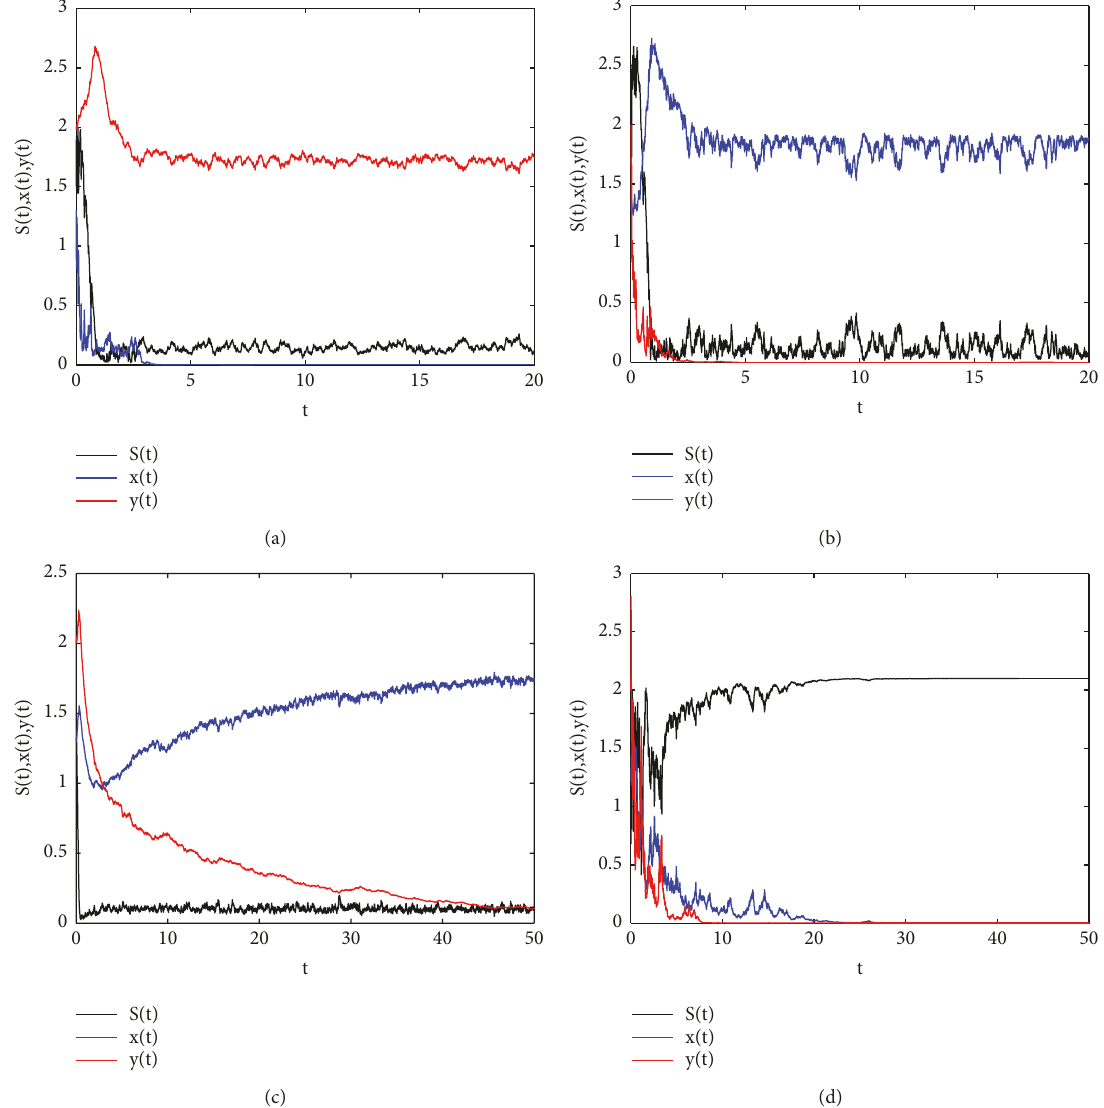
Figure 2:Numerical simulation of the paths 𝑆(𝑡), 𝑥(𝑡),𝑦(𝑡) for thechemostatstochasticsystem (6), where(a) 𝜎 1 = 1.6, 𝜎 2 = 0.1.𝑅 1 = 0.9444 < = 1.0129 > 1. (b) 𝜎 1, R 2 (d) 𝑚 1 = 1.26,𝑚 2 = 1.47.𝜎 1 = 0.4,𝜎 2 = 0.7.𝑅 1 = 0.9944 < 1,𝑅 2 = 0.9970 <